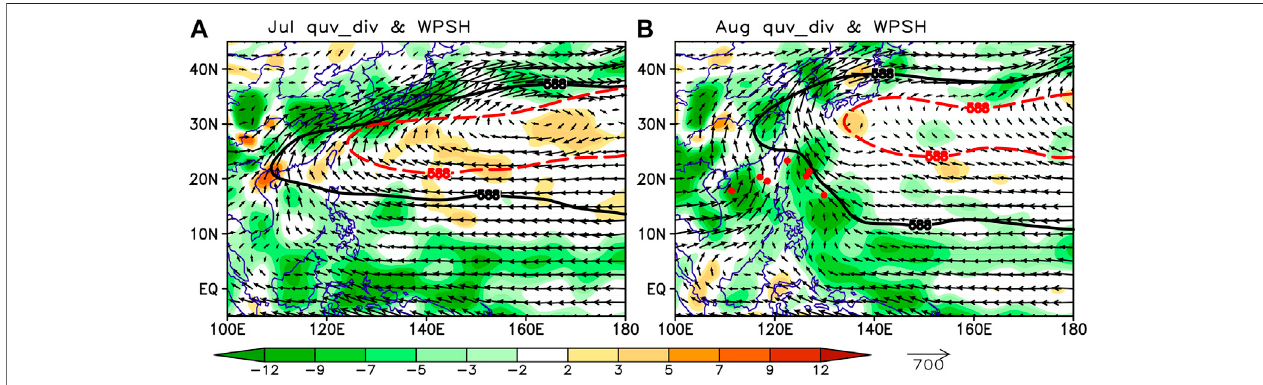
FIGURE 5 | Vertically integrated water vapor transport between surface and 300 hPa (vector, kg · m − 1 · s − 1 ) and divergences (shading, 10 − 5 kg s − 1 · m − 2 ) in (A) July and (B) August2020.Thereddotsin (B) indicatethelocationsofTCgeneses.Theblacksolidandreddashedcontoursof5880gpmin (A,B) indicatethewesternPaci fi c subtropical high in 2020 and climatology, respectively.